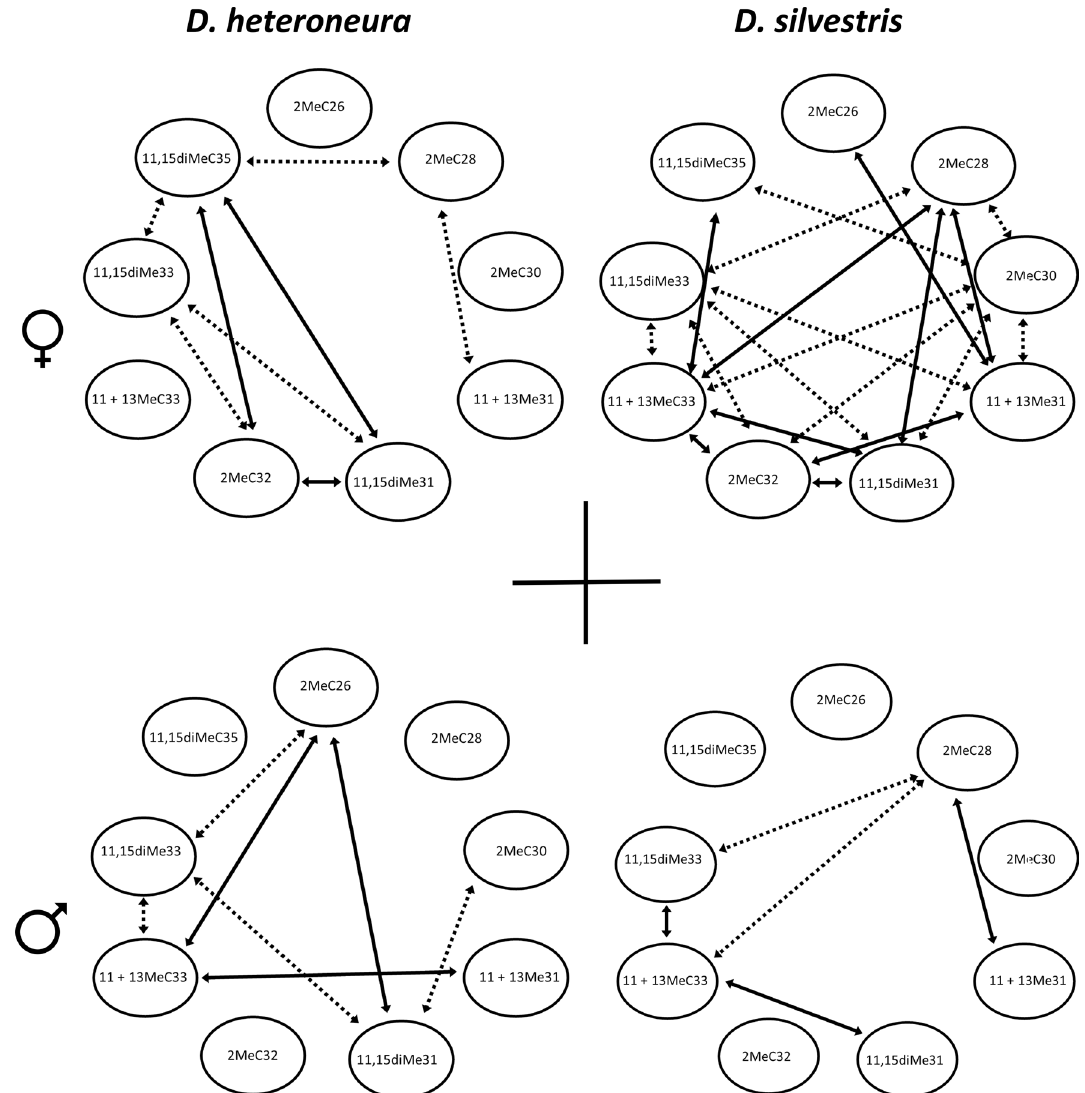
Figure 1. Correlation graph showing the strongest correlations among the nine CHCs in the parental species. D. heteroneura females (n = 10) in the upper left, D. silvestris females (n = 10) in the upper right, D. heteroneura males (n = 10) in the lower left and D. silvestris males (n = 10) in the lower right panel. The solid lines indicate the strongly positive correlations (r > 0.6, P < 0.05), and the dashed lines indicate the strongly negative correlations (r < − 0.6, P < 0.05), between compounds. Graph drawn in MSWord from correlations between CHCs in females and males of both species presented in Tables S1 and PC1 scores for CHC abundance in the two classes of backcross males were closer to the parental species to which they were backcrossed but unique to each class of males (Fig. 2B,C; Table S11). For PC2 and PC3, the back- cross males were not significantly different from D. silvestris and D. heteroneura males. Both types of backcross females were closer in overall CHC abundances to D. heteroneura females for PC1 and significantly different from D. silvestris; in contrast, for PC2, both backcross females were significantly different from D. heteroneura but not from D. silvestris females (Fig. 2C, Table S12). The abundances of individual compounds showed a range of patterns across backcross and parental-species genotypes. Four compounds (2MeC26, 2MeC28, 2MeC30, and 11 + 13MeC31) differed significantly in abundance between BC-H and BC-S backcross males, being similar in abundances to the same compounds in the parental species to which they were backcrossed. For the 11,15diMeC31 compound, the backcross males were significantly different from D. heteroneura and similar to D. silvestris (Table 2). The other compounds (2MeC32, 11 + 13MeC33, 11,15diMeC33, 11,15diMeC35) did not differ between the BC-H and BC-S backcross males, generally showing abundances intermediate to those of males of the two parental species. Similarly, the abundances of individual compounds in BC-H and BC-S backcross females differed significantly from each other for three compounds (Table 3: 2MeC26, 2MeC28, and 11 + 13MeC31). For 2MeC30 and 11,15diMeC33, the two types of backcross females were similar to each other and significantly different from both parental species with the abundance of